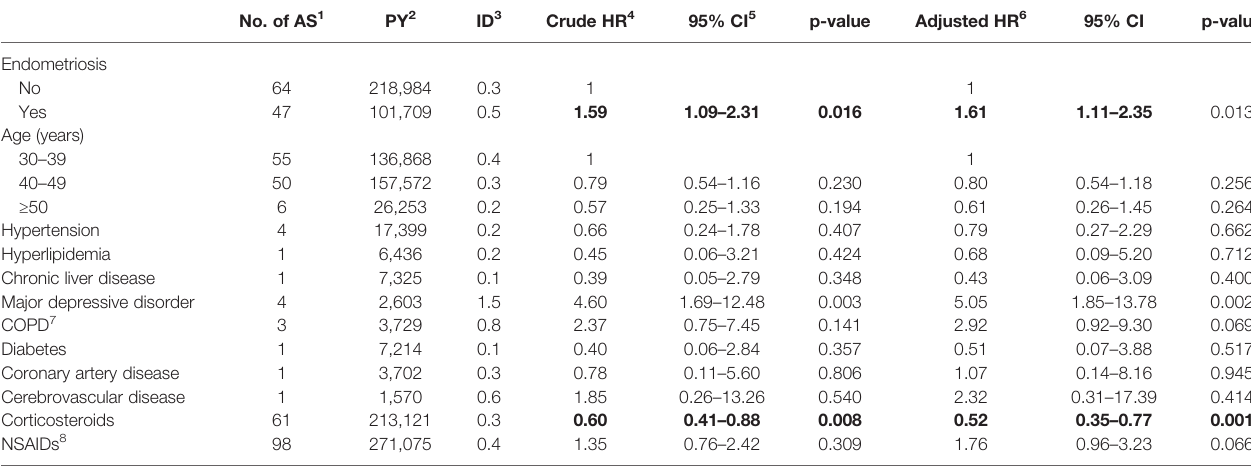
TABLE 2 | Risk assessment of AS with endometriosis, age, other health problems or medications. No. of AS 1 PY 2 ID 3 Crude HR 4